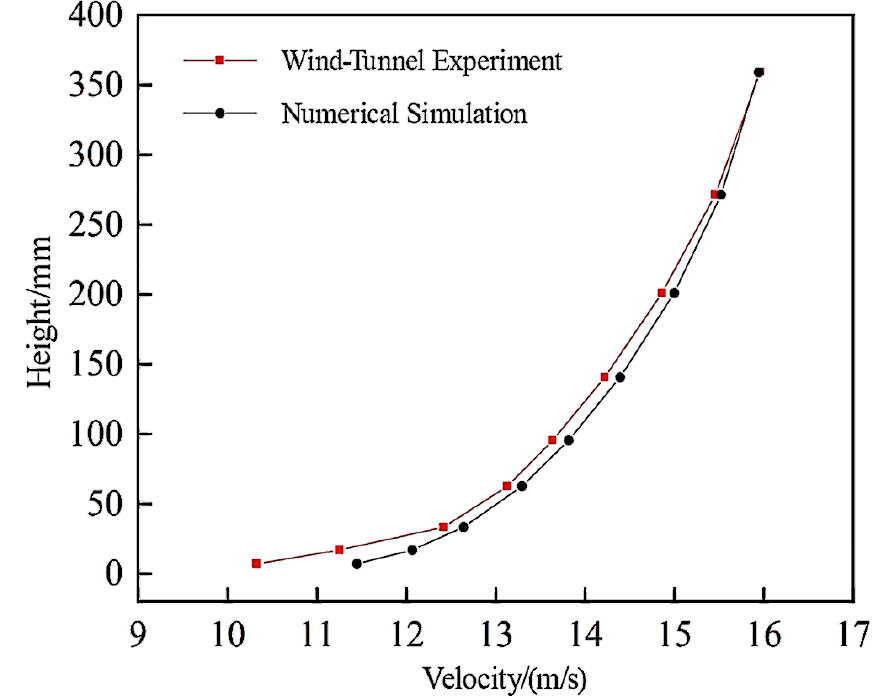
Figure 8. Comparison of wind speed profiles between wind tunnel test and numerical simulation.